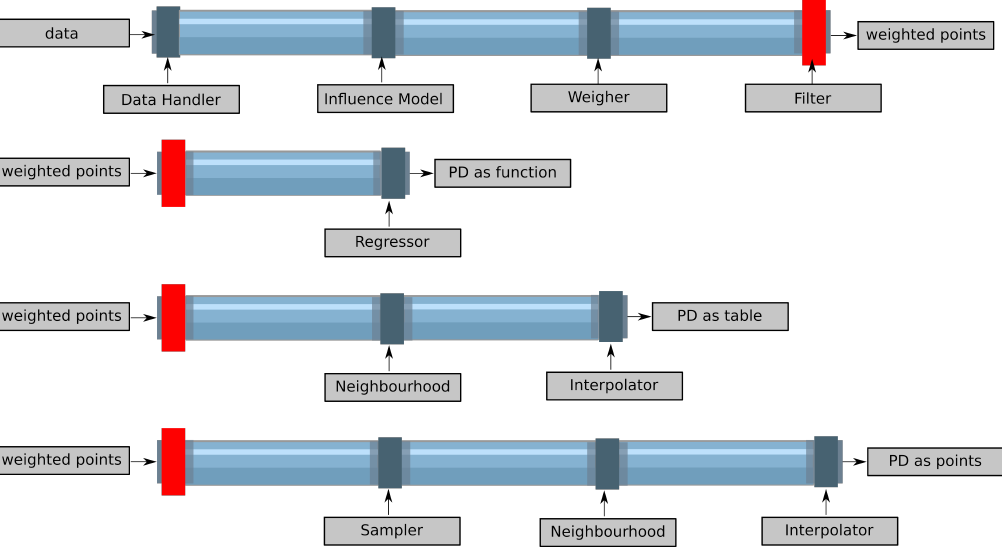
Figure 7. Pipeline model to obtain polar diagrams (PDs) from real-world